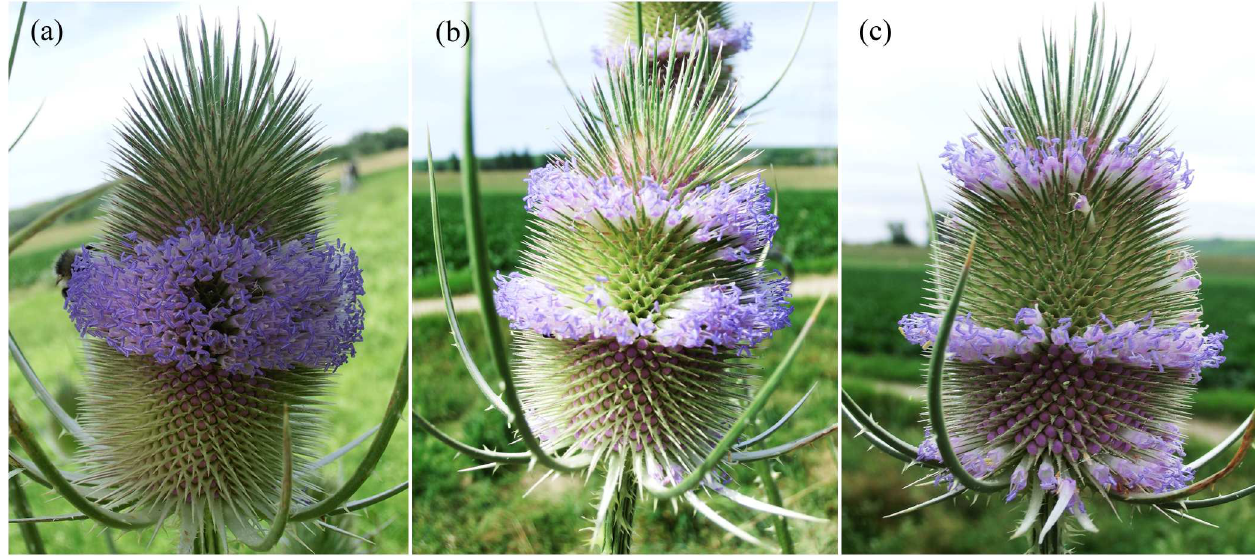
Fig 1. Bidirectional flowering in the head of Dipsacus fullonum . (a) The middle flowers start flowering.(b, c) Floweringsequenceproceeds both upwardand downward